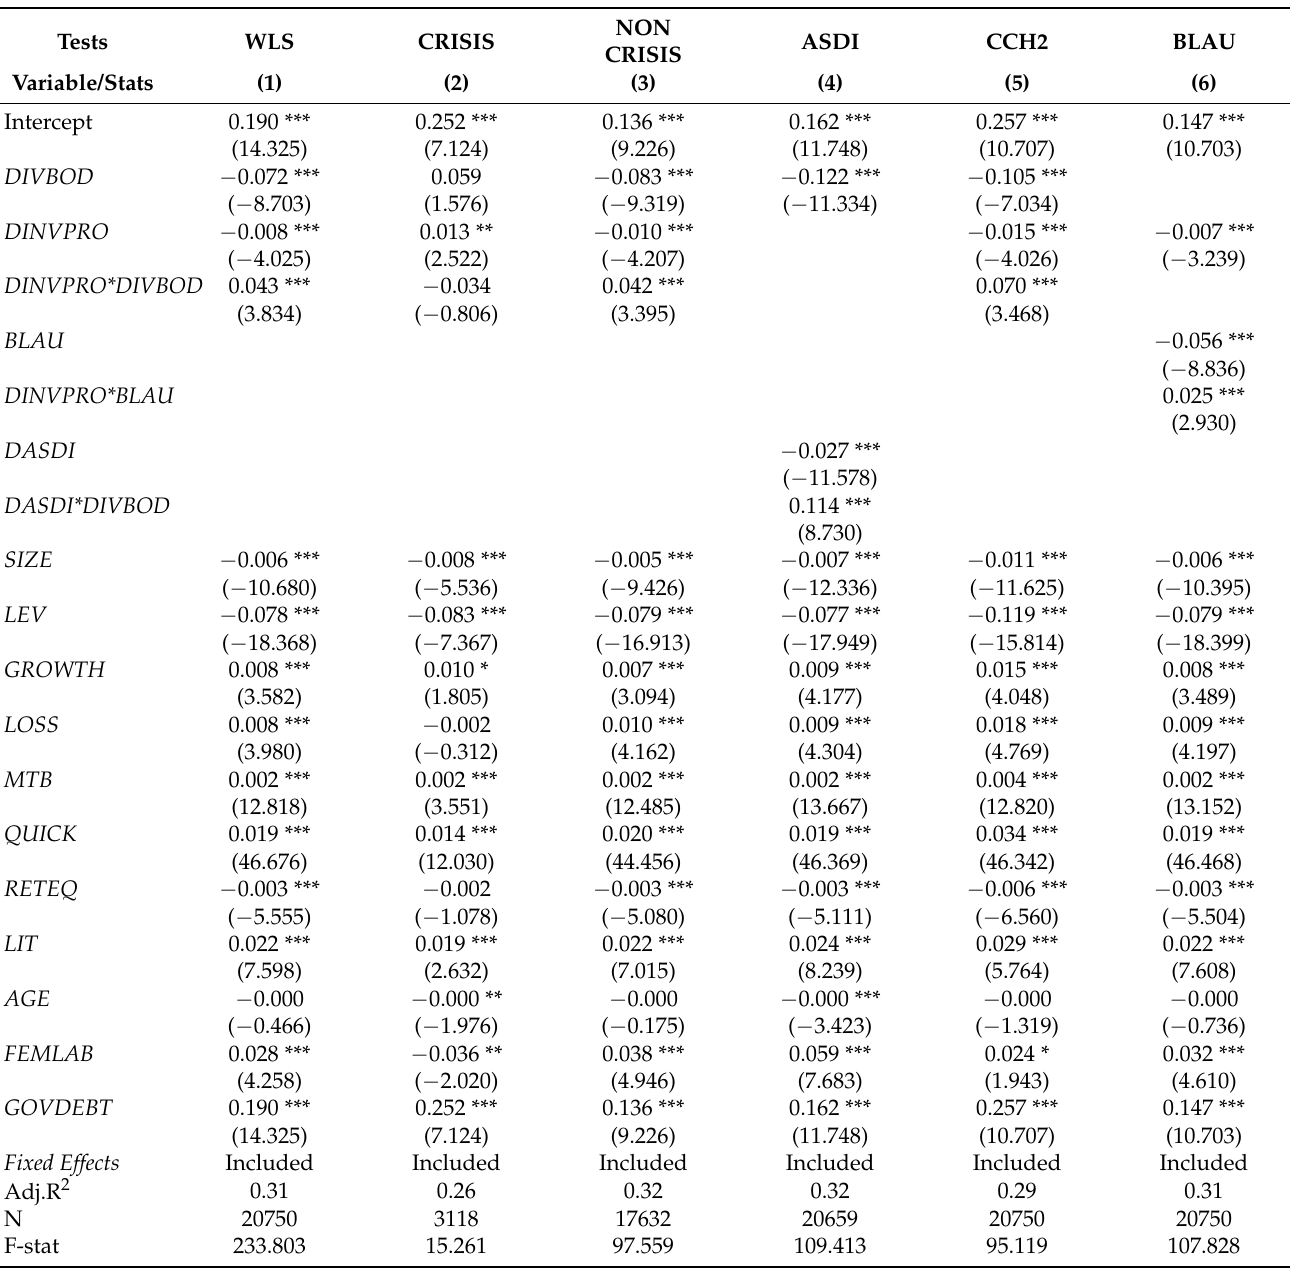
Table 4. Robustness tests: regression estimates of the effect of investor protection and board diversity on corporate cash